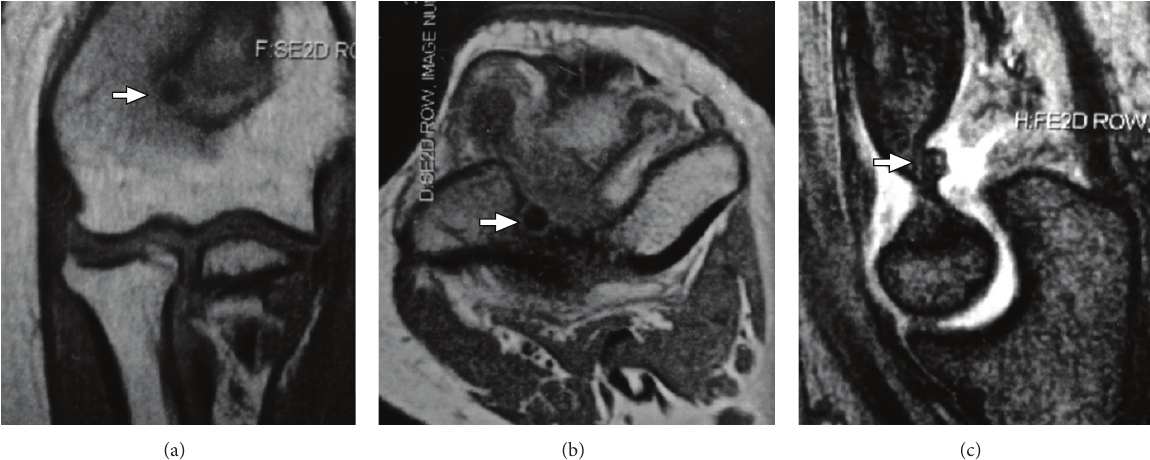
Figure 4: Magnetic resonance image of the nidus located subchondrally and a marked sclerotization of the surrounding bone. No cortical lesion indicating the presence of OO. Signs of mild synovitis were